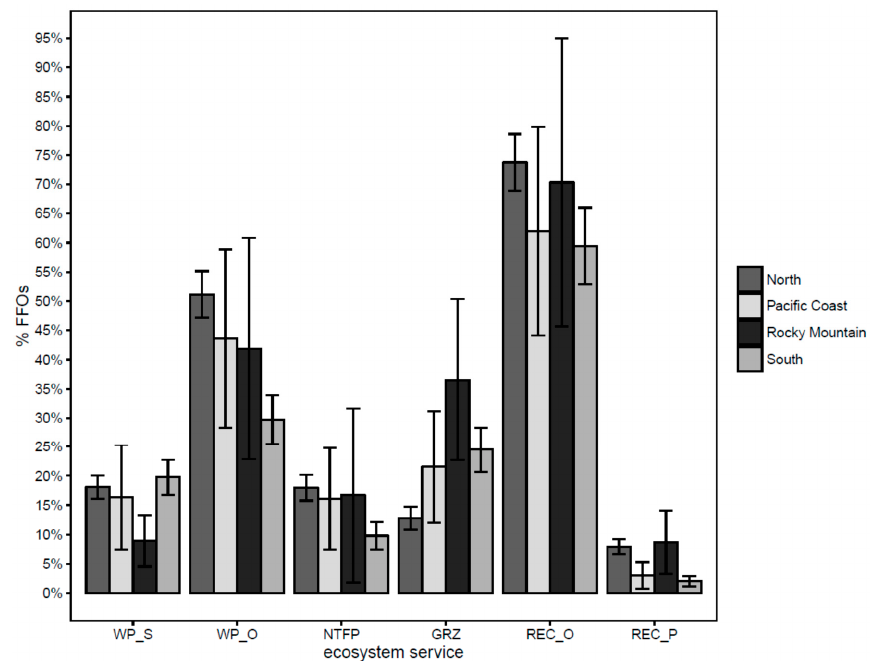
Figure 6. Estimated proportion of family forest ownerships (4+ ha) providing a selection of ecosystem services in the past 5 years, by ecosystem service and region, United States, 2011–2013. Error bars represent two standard errors. Regional boundaries are consistent with the USDA RPA assessment regions [23]. WP_S = wood products for sale, WP_O = wood products used by owners, NTFP = non-timber forest products, GRZ = grazing, REC_O = recreation by owners, REC_P = free public recreation.